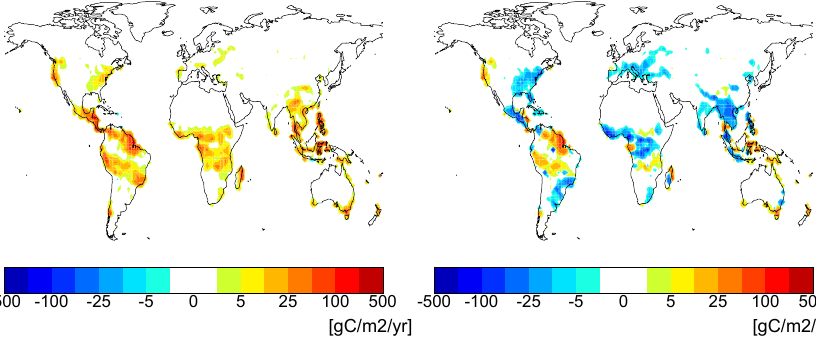
Fig. 8. Change in annual mean fire emissions in [gC/(m 2 yr)] averaged over 2075–2099 introduced by changes in population density. Simulations with transient varying forcings are compared to a control simulation in which the forcing is kept constant at preindustrial level. Left side: only human ignition considered (AB-HI-45-E1 minus AB-HI-PI-45-E1); right side: human ignition and fire suppression considered (AB-HI-FS-45-E1 minus